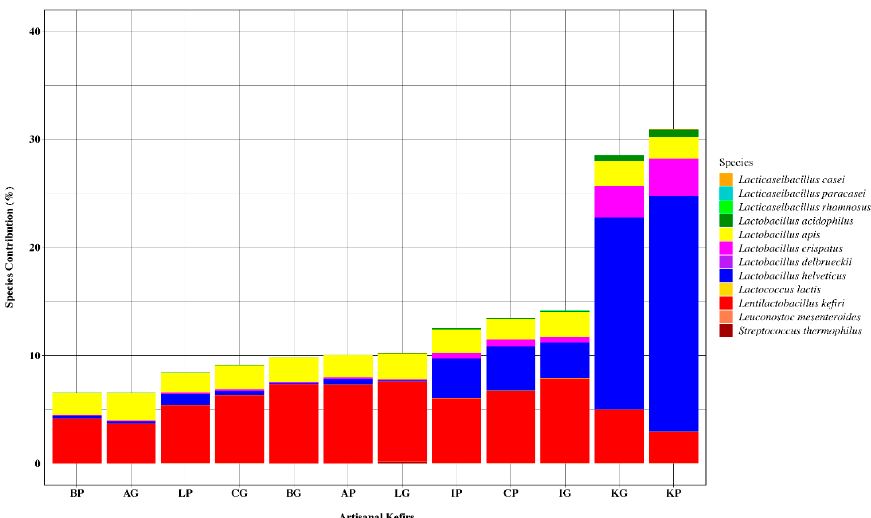
Figure 3. The 16S rRNA gene sequencing results showing percent species contribution of lactic acid bacteria (LAB). The IP, and IG share the same ranking with CP: L. apis , L. helveticus, L. acidophilus, and L. crispatus. The CG shares with IP, IG, and CP the same ranking for L. crispatus and L. acidophilus only. The LG has the highest relative abundance for S. thermophilus and the lowest relative abundance for L. helveticus when compared to LP as well as other artisanal kefirs. Kefir K was a stand-alone kefir product with respect to the ranking of species with known bacteriocin production: L. helveticus, L. crispatus, Lent. kefiri, L. apis, and L. acidophilus . The most abundant LAB with known bacteriocin production capability was identified to be L. helveticus in KP with relative abundance of 21.8% and in KG with relative abundance of 17.8% (Figure 3). L. helveticus was found in other artisanal kefir products with relative abundance between 0.26% (BP) and 4.11% (CP) and in artisanal kefir grains with relative abundance between 0.13% (LG) and 3.34% (IG). Lactobacillus crispatus , another Lactobacillus species with known bacteriocin production, followed L. helveticus in KP and KG with relative abundance of 3.44% and 2.93%, respectively (Figure 3). The relative abundance for L. crispatus in other artisanal kefir products and kefir grains varied between 0.07% (BP) and 0.6% (CP) and between 0.045% (BG) and 0.51% (IG), respectively.